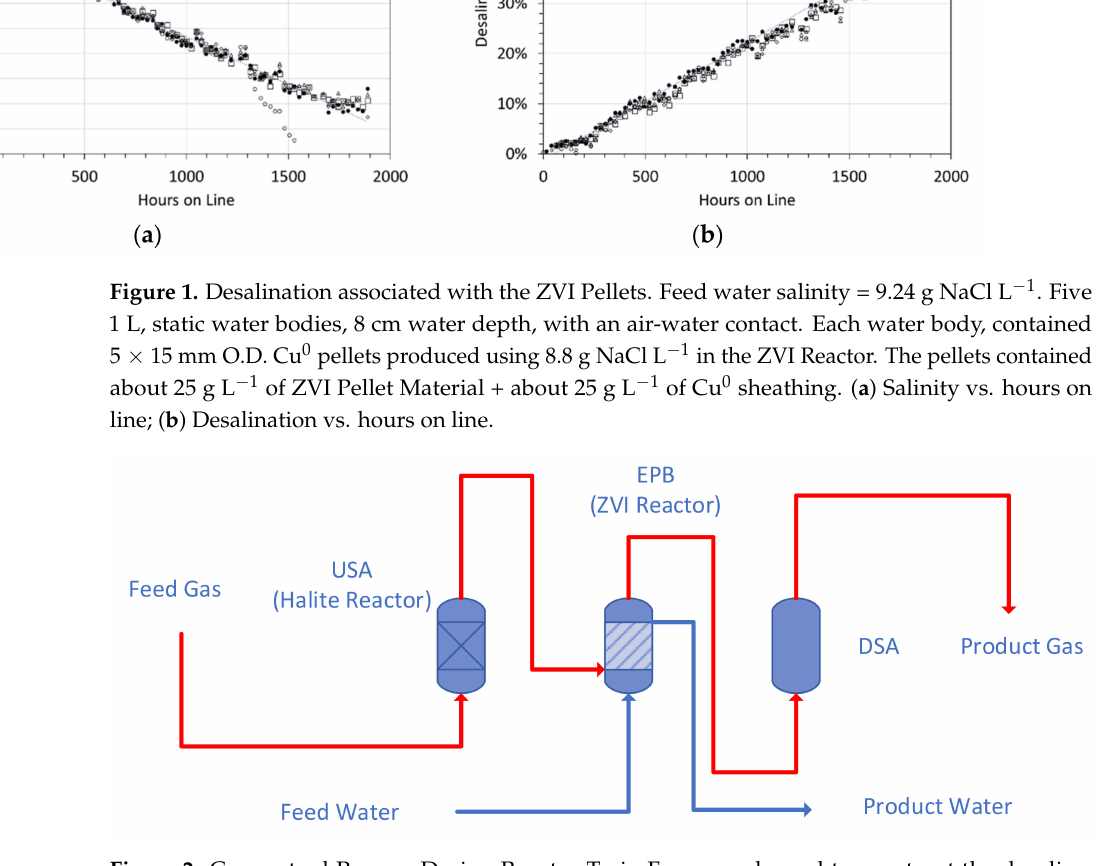
Figure 2. Conceptual Process Design Reactor Train Framework used to construct the desalina- tion